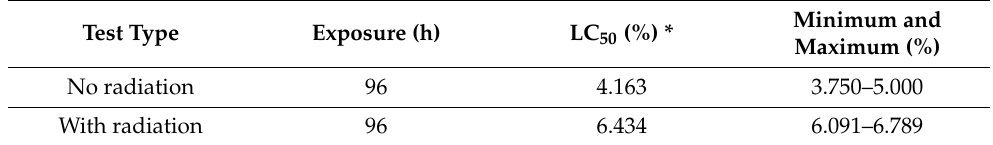
Table 3. Results of the acute toxicity assay using G. tigrina .